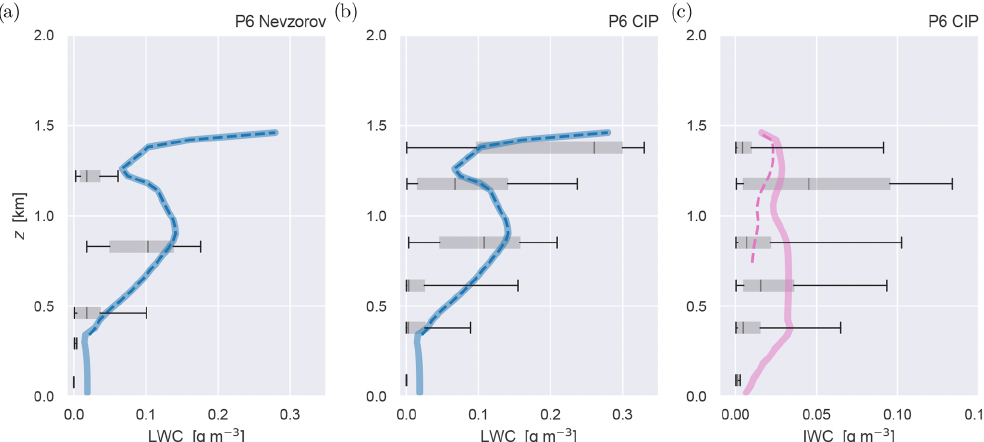
Figure 9. Simulated and observed hydrometeor masses. Panels (a) and (b) show liquid water content (LWC) sampled by the Nevzorov and CIP probes, respectively, while panel (c) shows the ice water content (IWC) measured by the CIP probe. Only samples during the southern racetrack segment of RF20 are included. The hourly mean LES results at t = 24h are shown in color and represent conditional averages over the area fraction covered by the associated hydrometeors. The thick colored line represents the sum of all liquid-phase hydrometeors (blue, q l + q r ) and ice-phase hydrometeors (pink, q i + q s + q g ) in the model. The thin dashed line represents only the suspended species ( q l and q i , respectively). The grey box–whisker plots represent the P6 measurements in the racetrack section, with the 5th–95th percentile range (black line) and the interquartile range (grey box) indicated. The Nevzorov data are analyzed on five separate level flight legs, while the CIP data are vertically gridded at 250m spacing.